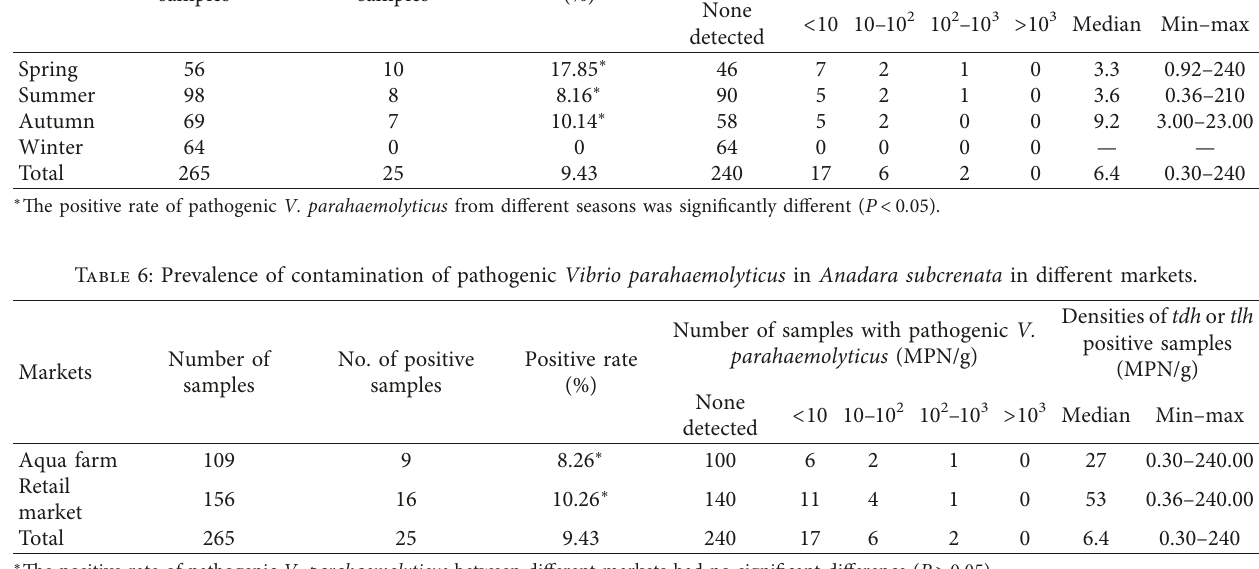
Table 5: Prevalence of contamination of pathogenic Vibrio parahaemolyticus in Anadara subcrenata in different seasons. Number of Seasons Spring